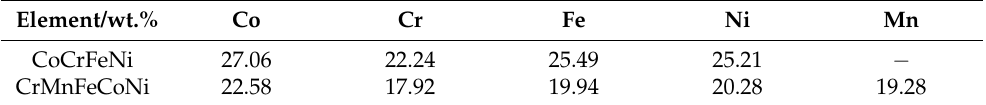
Table 1. Chemical compositions of the CoCrFeNi and CrMnFeCoNi MPEAs in weight percent measured by inductively coupled plasma mass spectrometry.